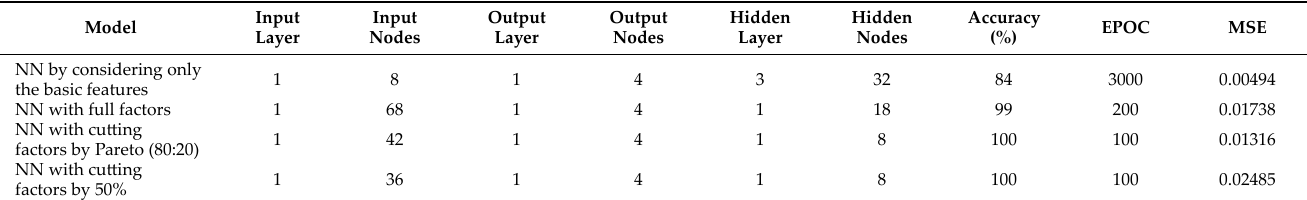
Table 3. Summary of model predicting the results of selecting the services of financial institutions by using